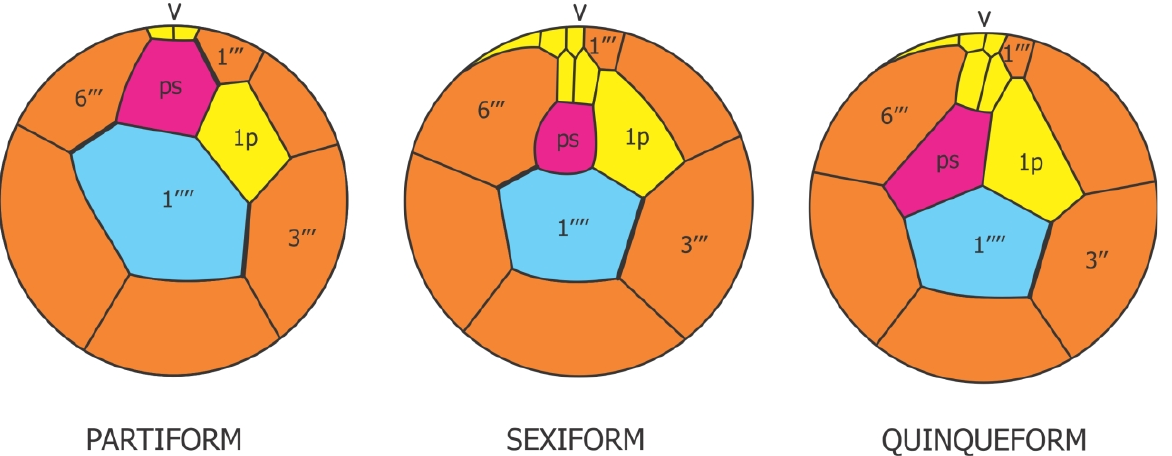
Figure 19. Variations on the tabulation of the gonyaulacalean hyposome; the labelling of the plates follows the traditional Kofoidian style. Postcingular plates are shown in orange; the postcingular plate is in blue; the posterior sulcal plate or its homologue is shown in red, and other plates are shown in yellow. In the quinqueform pattern, the single antapical plate is five-sided; in the sexiform pattern the antapical plate is six-sided and the anterior boundary of the ps plate abuts against the first posterior intercalary (1p) plate; in the partiform pattern the antapical plate is also six-sided, but the anterior boundary of the posterior sulcal (ps) plate abuts against the first postcingular (1 ′′′ ) plate. Based on [62].